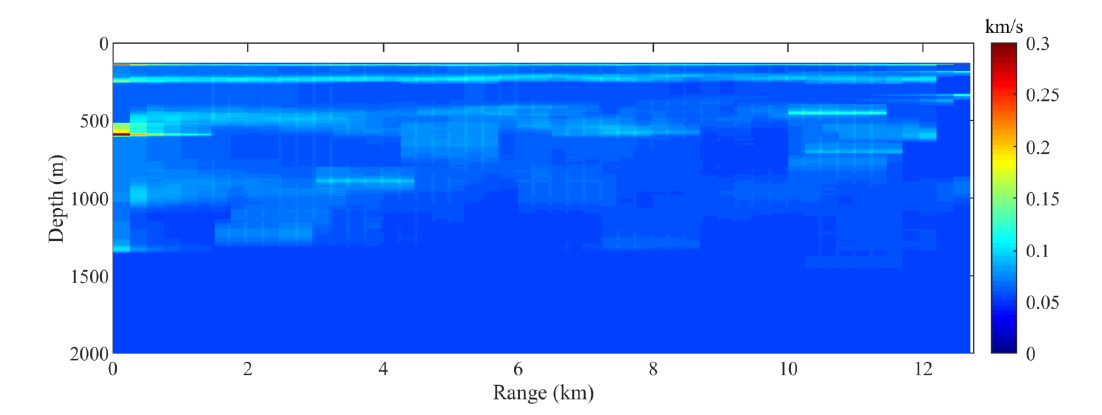
Figure 12. A vertical slice of the standard deviation of the resolved shear-wave subsurface structure under the 10th cable counted from left to right of the PRMRA in Figure 1.